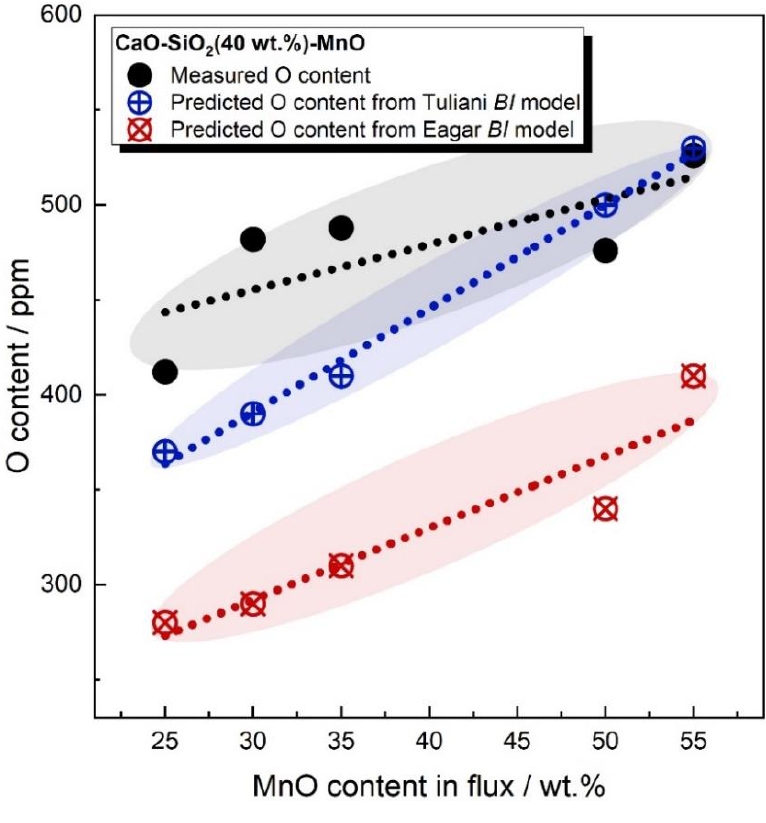
Figure 5. WM O content as a function MnO content in flux.